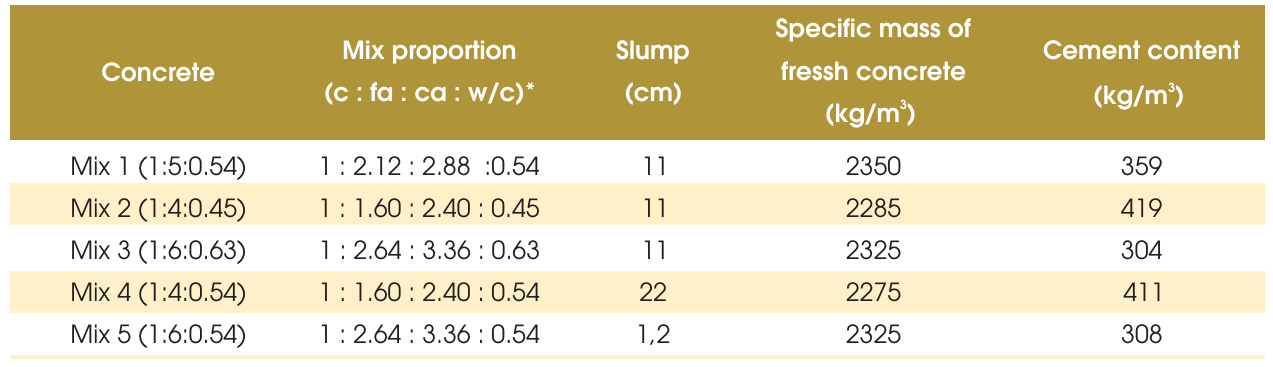
Table 3 – Mix proportions, slump test results and specific mass of fresh concrete